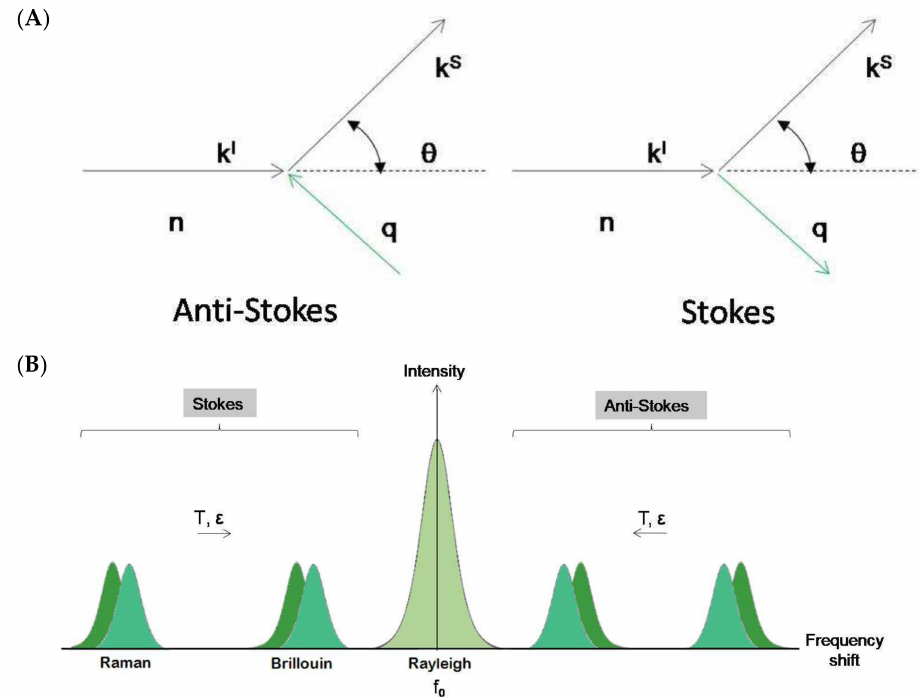
Figure 2. ( A ). Schematic representation of the Brillouin–Mandelstam effect as a collision between photon ( k l ) and phonon ( q ). n is the refractive index of the physical medium and θ is the scattering angle. ( B ). Schematic representation of Brillouin and Raman spectra. In both experimental techniques, a small amount of light undergoes inelastic scatter, gaining or losing energy and giving rise to a couple of symmetric, frequency-shifted peaks in the spectrum. The remaining elastically scattered light (Rayleigh scatter) appears as a broad central peak with the same frequency as the incident light ( f 0 ). In Brillouin and Raman spectroscopies, peak frequency position varies with temperature ( T ) and strain ( ε ). In Raman spectroscopy, the intensity ratio between Stokes and anti-Stokes peaks varies also with T